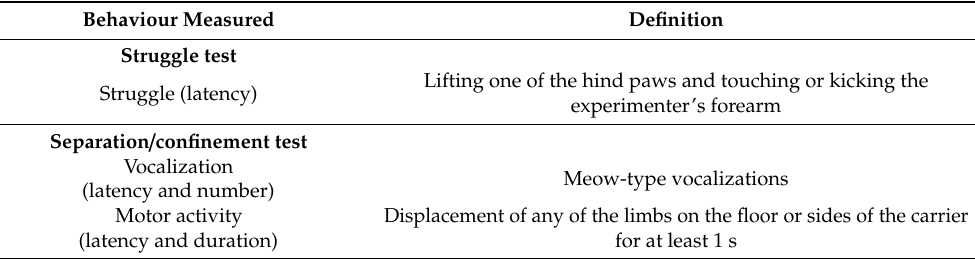
Table 1. Behavioural variables recorded in each